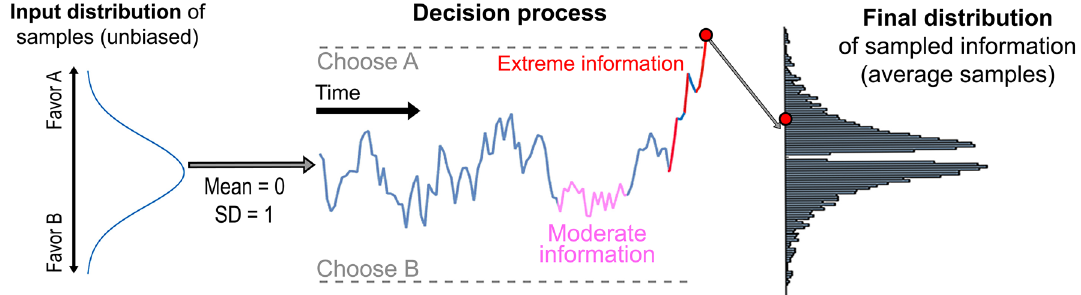
Figure 1. Illustration of how an unbiased distribution of information (left) becomes a polarized distribution (right) when fed through the decision process (middle). Because of an incentive to choose between options, moderate information—since it does not give credence to either options—gets discarded